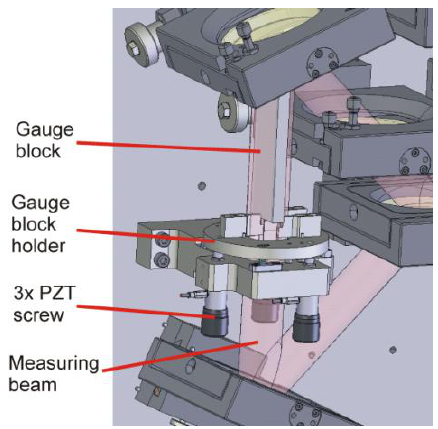
Figure 4. Sketch of the gauge block holder placed in the optical